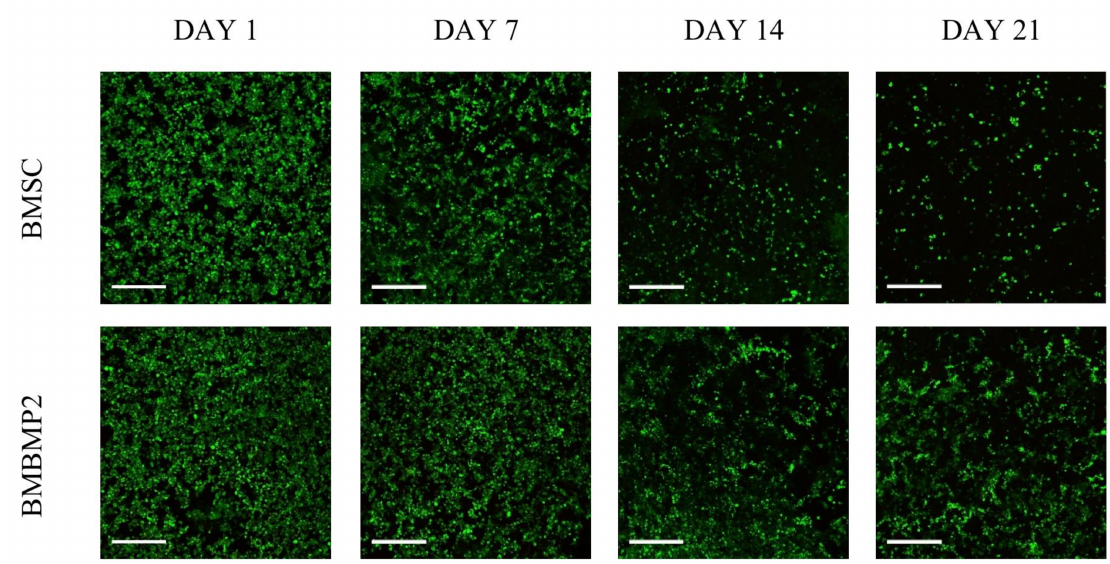
Figure 4. Immortalized mouse BMSCs photoencapsulated in visible light-cured thiol-acrylate hydrogels. Confocal mi- croscopy images of photoencapsulated-BMSCs with or without BMP-2: photoencapsulated-BMSCs without BMP-2 (BMSC), and photoencapsulated-BMSCs with BMP-2 (BMBMP2). BMSCs were stained with a live/dead cell staining kit (green = live cells, red = dead cells). Images were taken on days 1, 7, 14, and 21. Greater BMBMP2 viability is observed at days 14 and 21 compared to BMSCs. The scale bar is 100 µ m